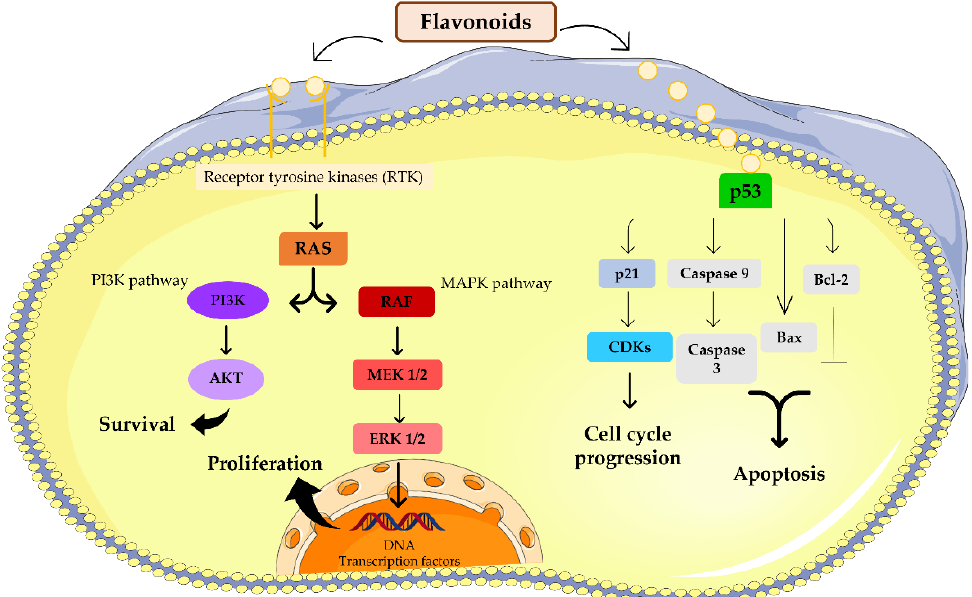
Figure 1. Molecular targets of flavonoids. Flavonoids target PI3K and the MAPK signaling pathway, inducing survival and proliferation of tumor cells. Additionally, flavonoids can also affect p53 and influence cell cycle progression by regulation of cyclin dependent kinases (CDKs) and by apoptosis.